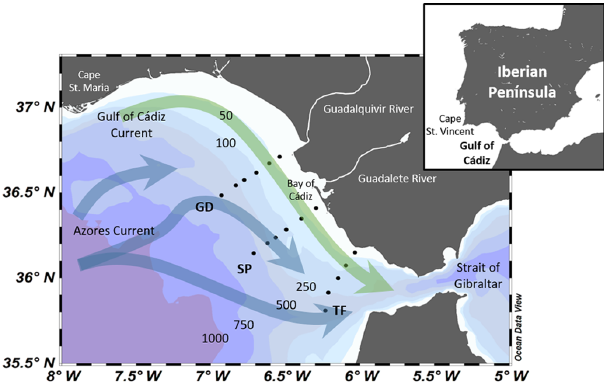
Figure 1. Map of the eastern shelf of the Gulf of Cádiz showing the location of the fixed stations located on three transects at right angles to the coastline: Guadalquivir (GD), Sancti Petri (SP) and Trafalgar (TF). The location of the principal surface currents, rivers and capes of the study area are also